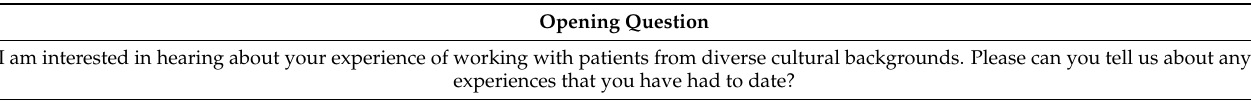
Table 2. Topic guide for semi-structured interviews with